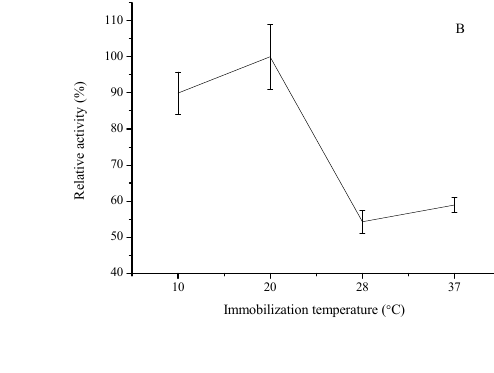
Figure 2. Cont. Figure 2.